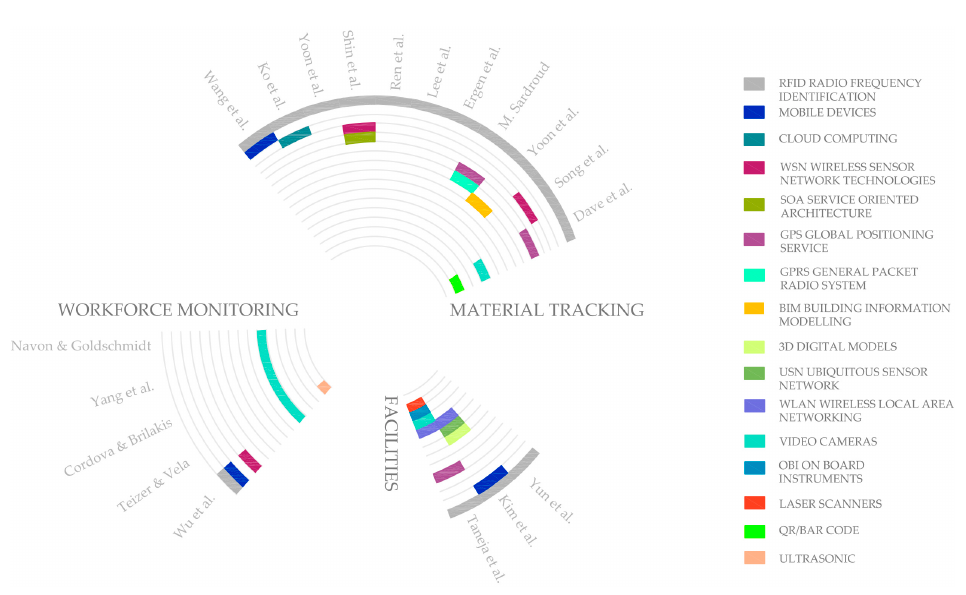
Figure 1. State of the art of smart sensors and data collection technologies applied to the construction of residential buildings.